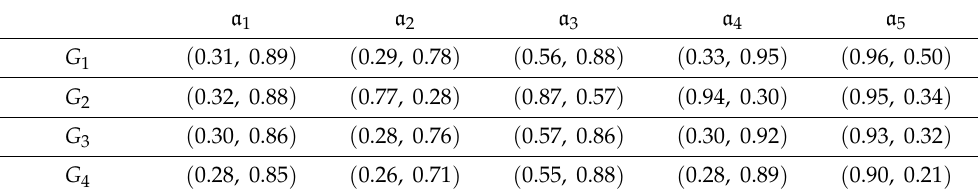
Table 2. q-ROF decision matrix.